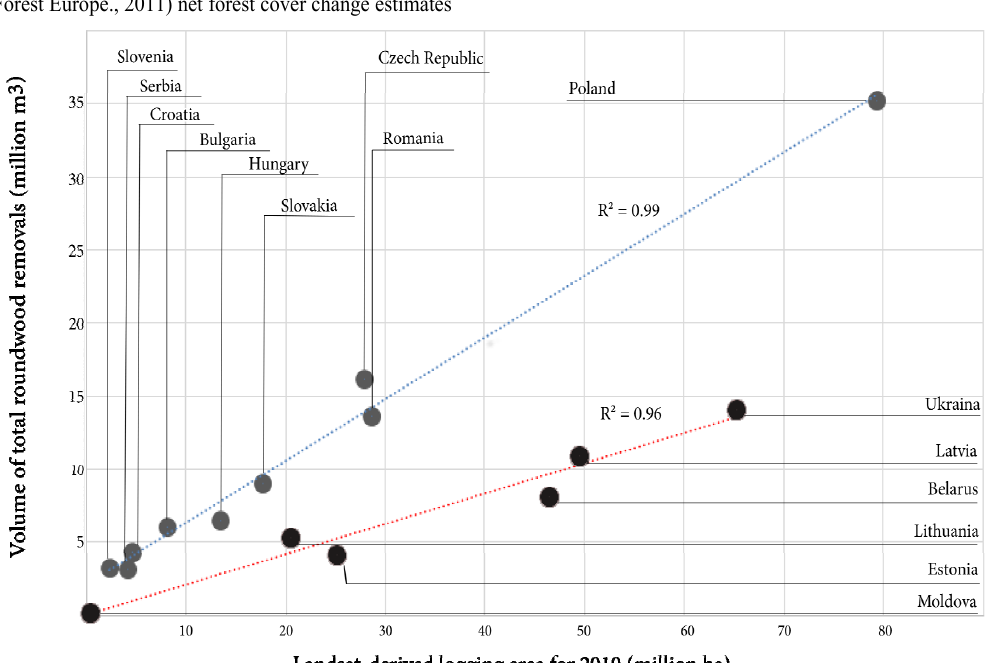
Figure 6. Relation between annual 2010 Landsat-based logging area (average for 2009-2011) and timber harvesting for year 2010 (Forest Europe., 2011) per